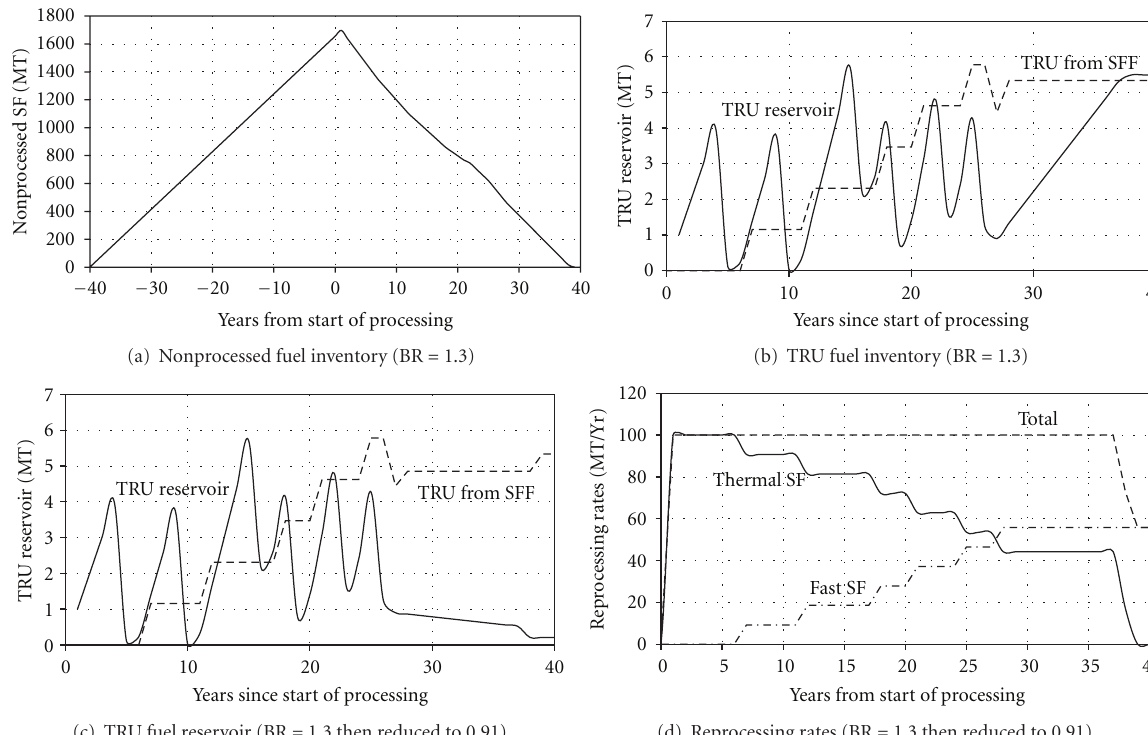
Figure 3: Conversion from two thermal to six fast spectrum plants (BR =